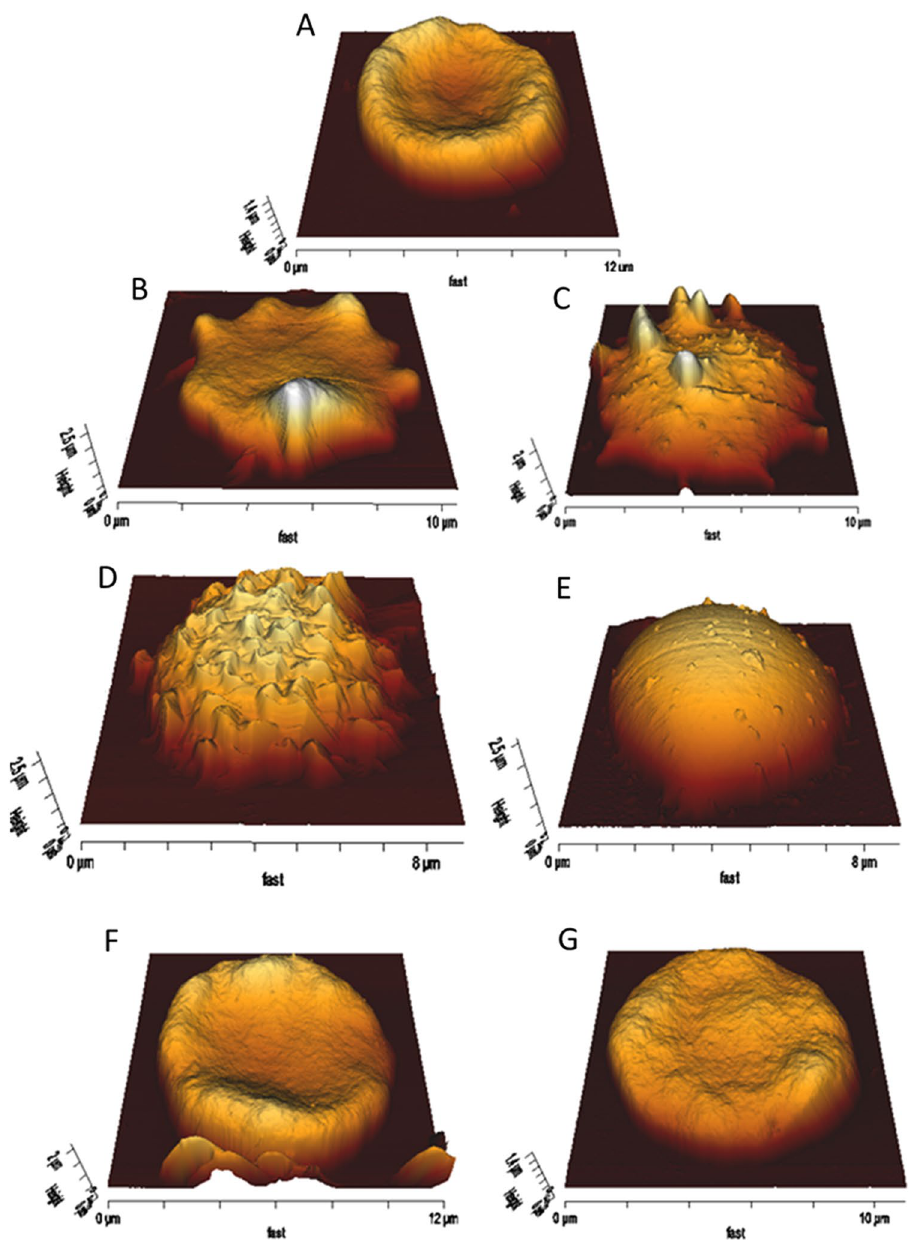
Figure 3. AFM monitorization of 10 µ M Pb 2 + effect on RBC. Exposure times: 0 min ( A ), 6 min ( B ), 30 min ( C ), 45 min ( D ), 60 min ( E ). Lead (II) effect on CLT-treated RBC, 20 min ( F ) and 15 h ( G